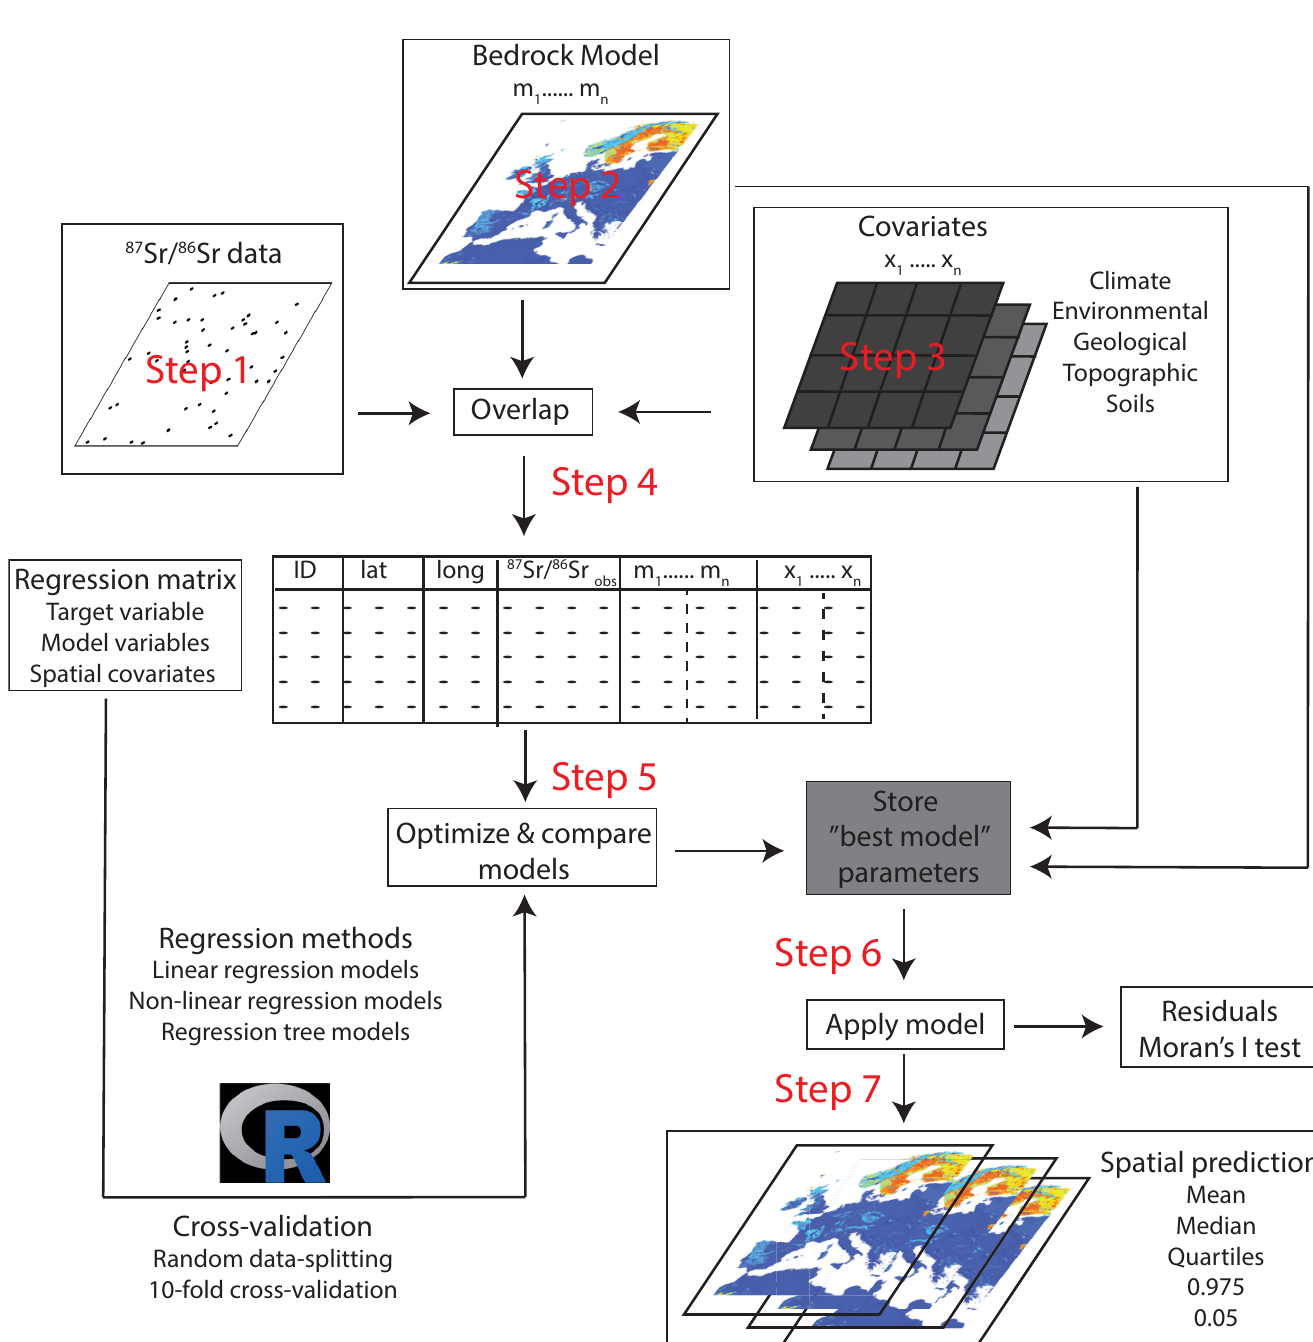
Fig 2. Flowchart summarizing the workflow used for the regression analysis. Tested covariates are given in Tables 1 and 2. The R script is provided in the supporting